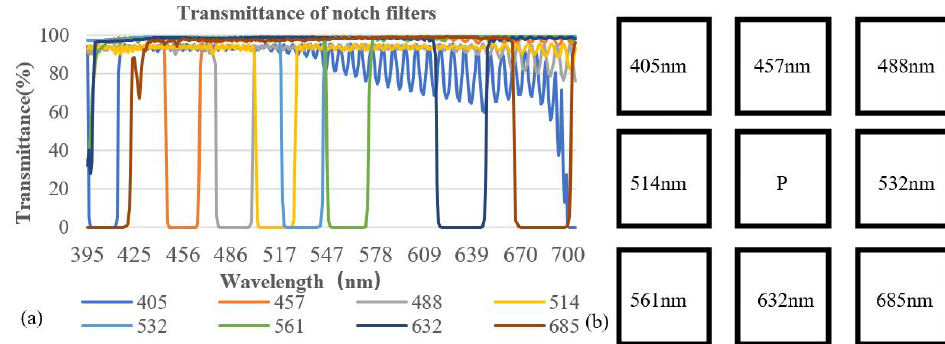
Figure 1. ( a ) Transmittance of notch filters and ( b ) their locations in the multi-aperture imaging system. P indicates the aperture used for capturing panchromatic images. The central wavelengths of the notch filters are 405, 457, 488, 514, 532, 561, 632, and 685 nm.